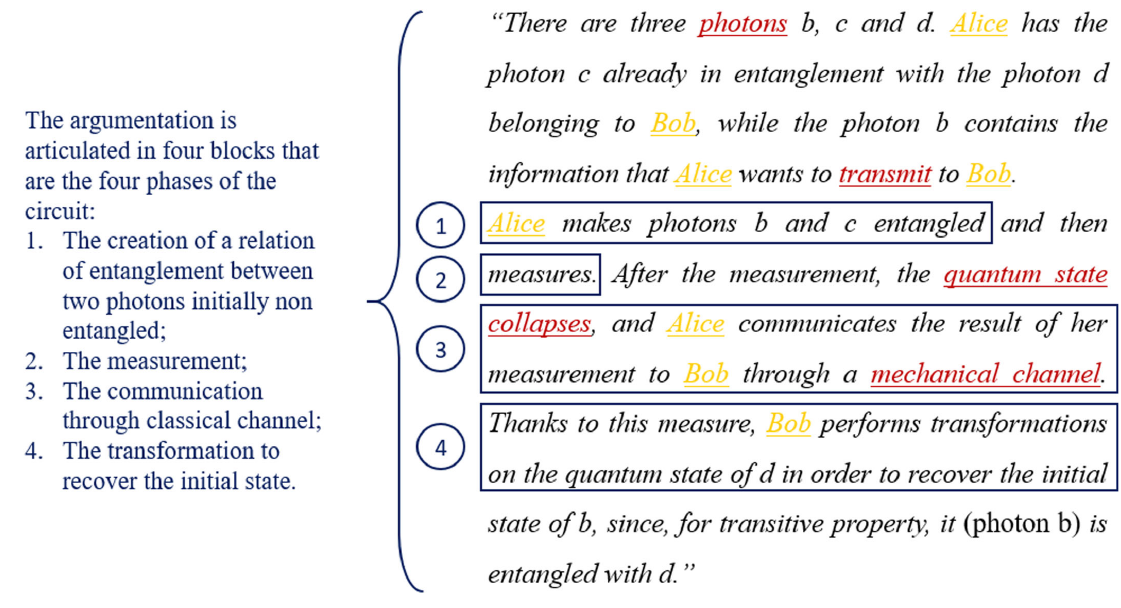
FIG. 23. Analysis of answer #1 — on the left the structure of the discourse; in yellow the “ main actors ” ; in red the key-words characterizing the